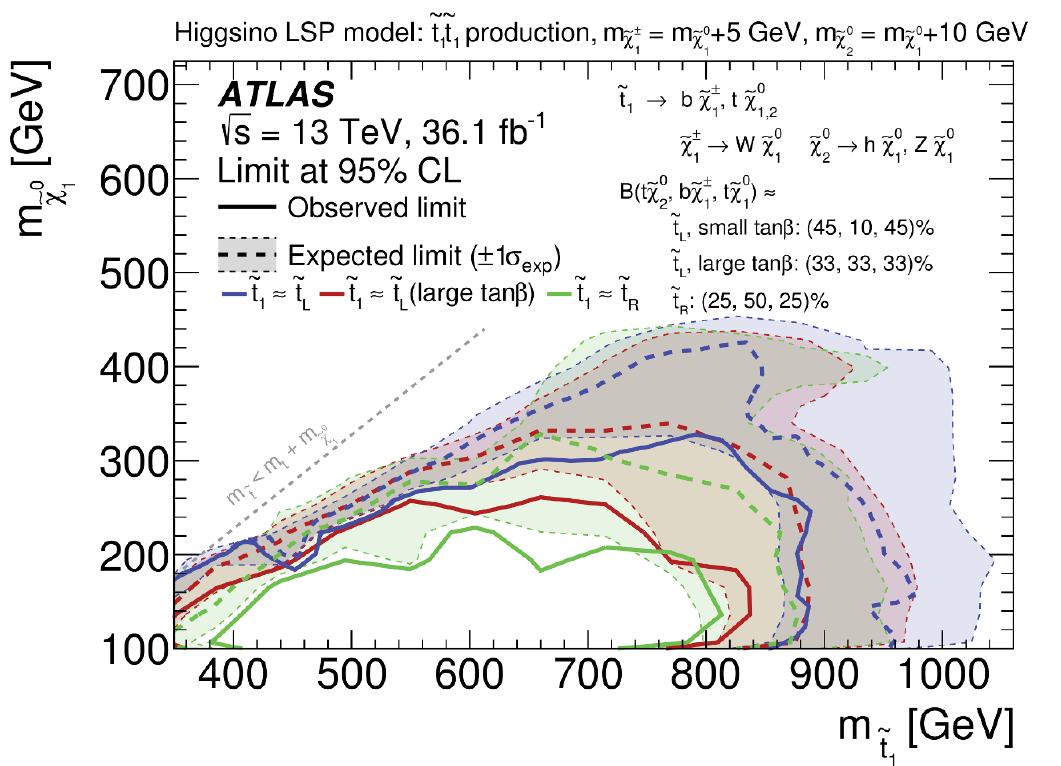
Figure 25 . Expected (dashed) and observed (solid) 95% excluded regions in the plane of m m ~ for direct stop pair production in the higgsino LSP model where various decay modes (~ t t 1 ~ t t ~ (cid:31) 0 1 , ~ t t ~ (cid:31) 0 2 ) are considered with di(cid:11)erent branching ratios depending on the hypothesis 1 ! 1 ! being considered. In this model, (cid:1) m (~ (cid:31)